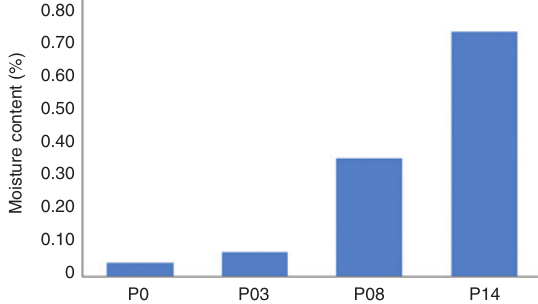
Figure 8 represents the FTIR spectra of the polypropylene filaments. The absorption bands at 2950, 2918, and Figure 5: Moisture content of the polypropylene filaments.